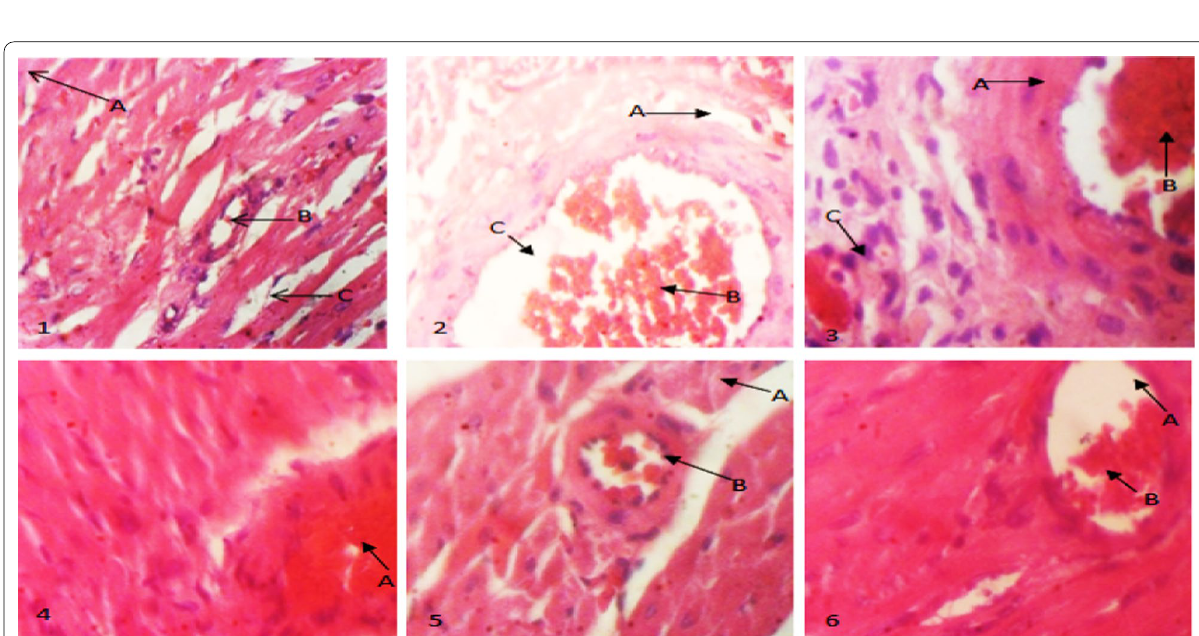
Fig. 10 Effect of n-hexane leaf extract of Ipomoea batatas L . on the heart. Pic (1) represents c ontrol rat heart composed of: A—bundles of myocardial fibres, B—coronary vessel and C—interstitial space, (2) phenylhydrazine alone showed; A—dilated coronary vessel with B—mild vascular congestion, (3) at 5 mg/kg of ferrous (iii) hydroxide showed; A—dilated coronary vessel, B—mild vascular congestion and C—heavy infiltrates of inflammatory cells, (4) at 125 mg/kg n-hexane extract showed A—moderate vascular congestion (5) at 250 mg/kg n-hexane extract showed A—normal my cardiac fibres and B—normal coronary vessel (6) at 500 mg/kg n-hexane extract showed A—moderate vascular dilation and B—mild congestion. They were using haematoxylin–eosin dye with X 40